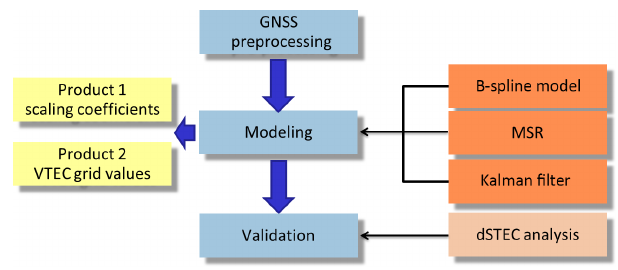
Figure 15. DGFI-TUM’s processing modules, including (blue boxes) the download and preprocessing module for GNSS obser- vations, the modeling module by means of B-splines, MSR and Kalman filtering (orange boxes) with possible output as Product 1 and Product 2 (yellow boxes) and the validation